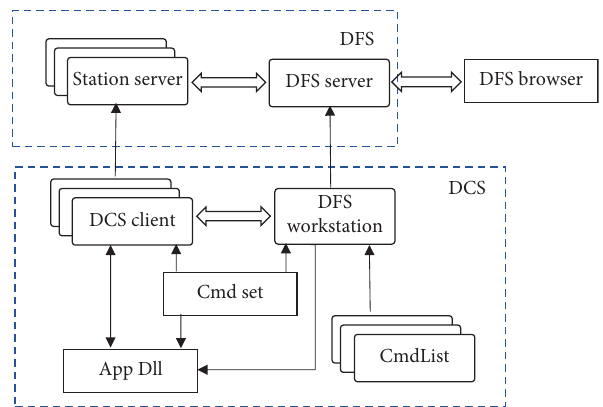
Figure 2: Structure of a distributed file system.